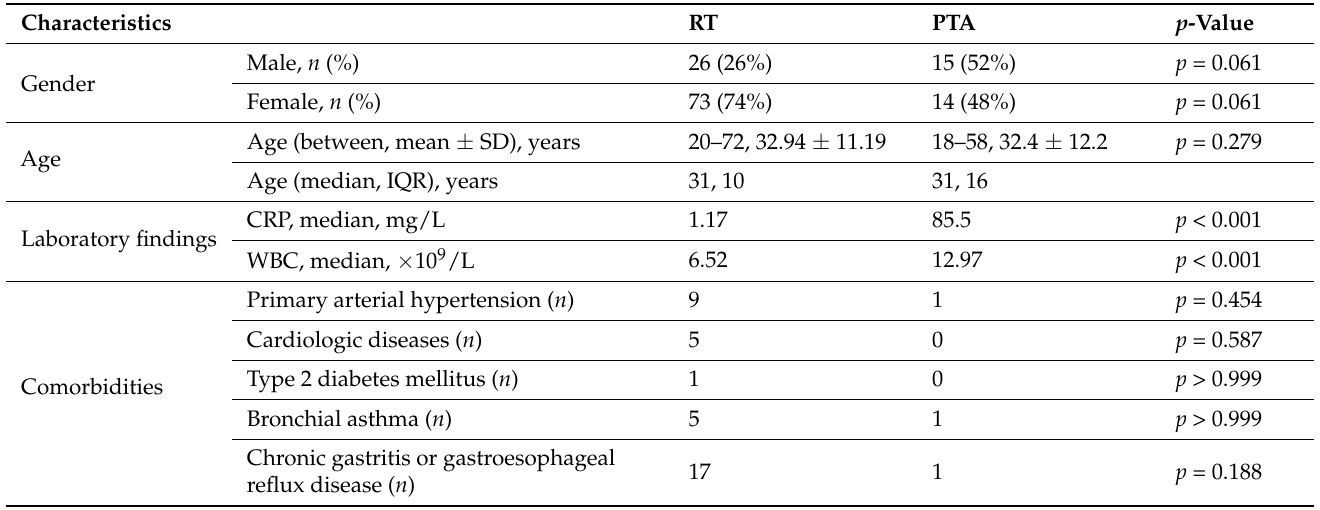
Table 1. General characteristics of the study